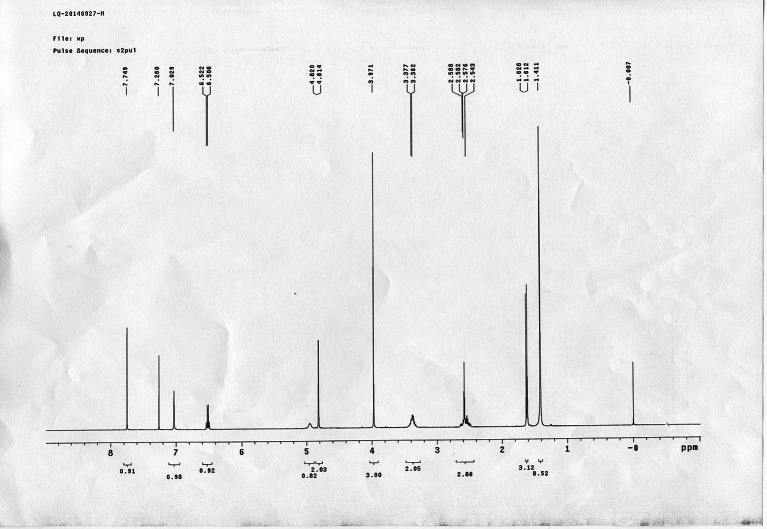
1H NMR spectra of compound 6.